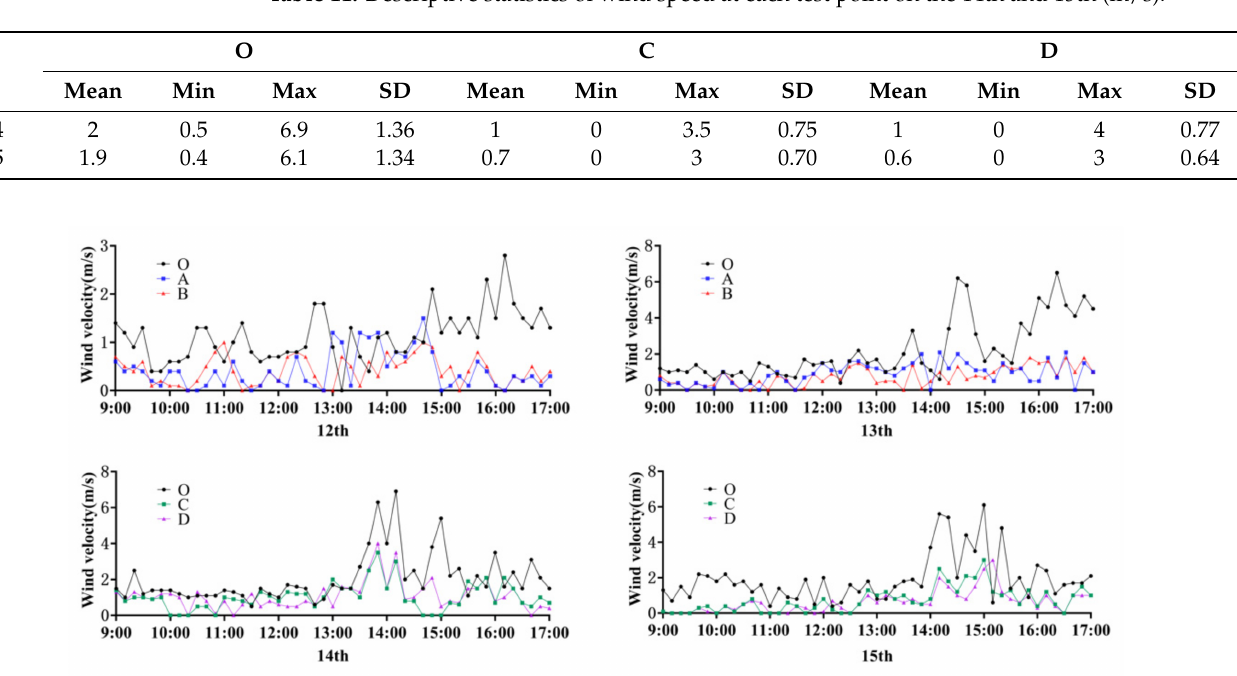
Table 11. Descriptive statistics of wind speed at each test point on the 14th and 15th (m/s).